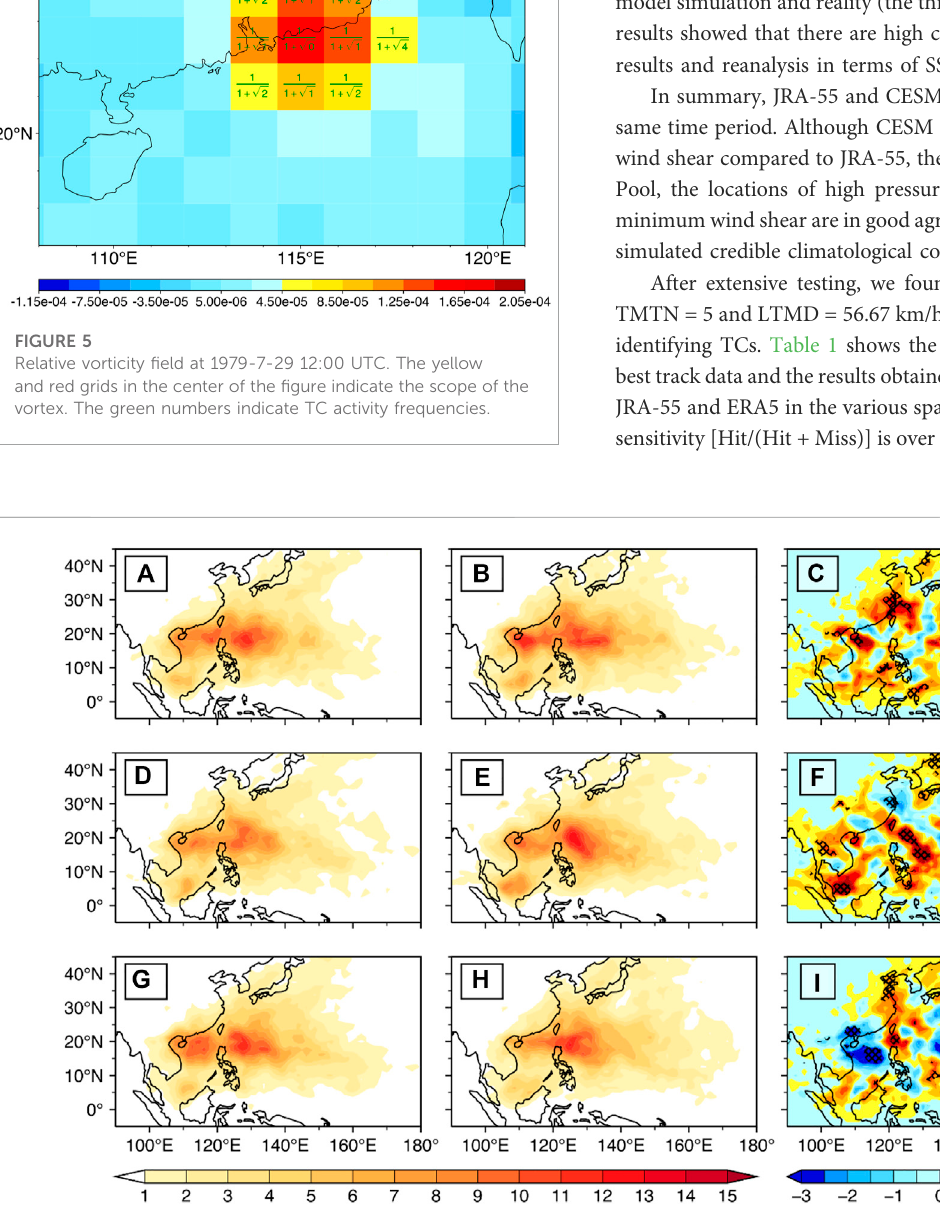
FIGURE 6 10-yearaccumulatedactivityfrequencyoftropicalcyclonesinthe1.5degNEscenario,fortheperiodsof (A) 2011 – 2020and (B) 2091 – 2,100. (C) is the difference between (A) and (B) . (D – F) , (G – I) show the same variable for the 1.5degOS and 2.0degNE scenarios, respectively. The area that passed the 95% signi fi cance test is covered by the